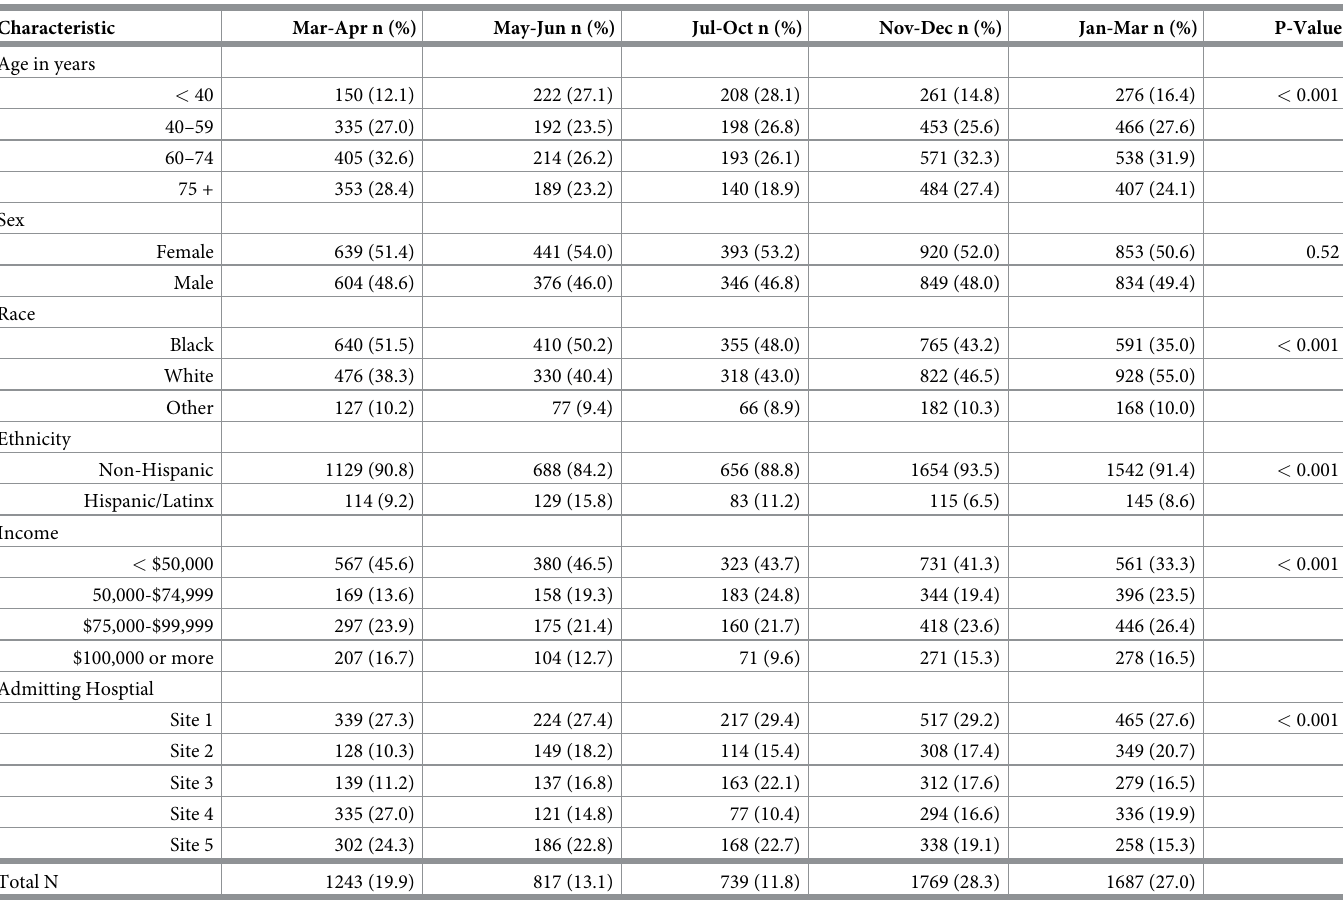
Table 1. Patient characteristics at COVID-19 hospital admission by timing of admission.